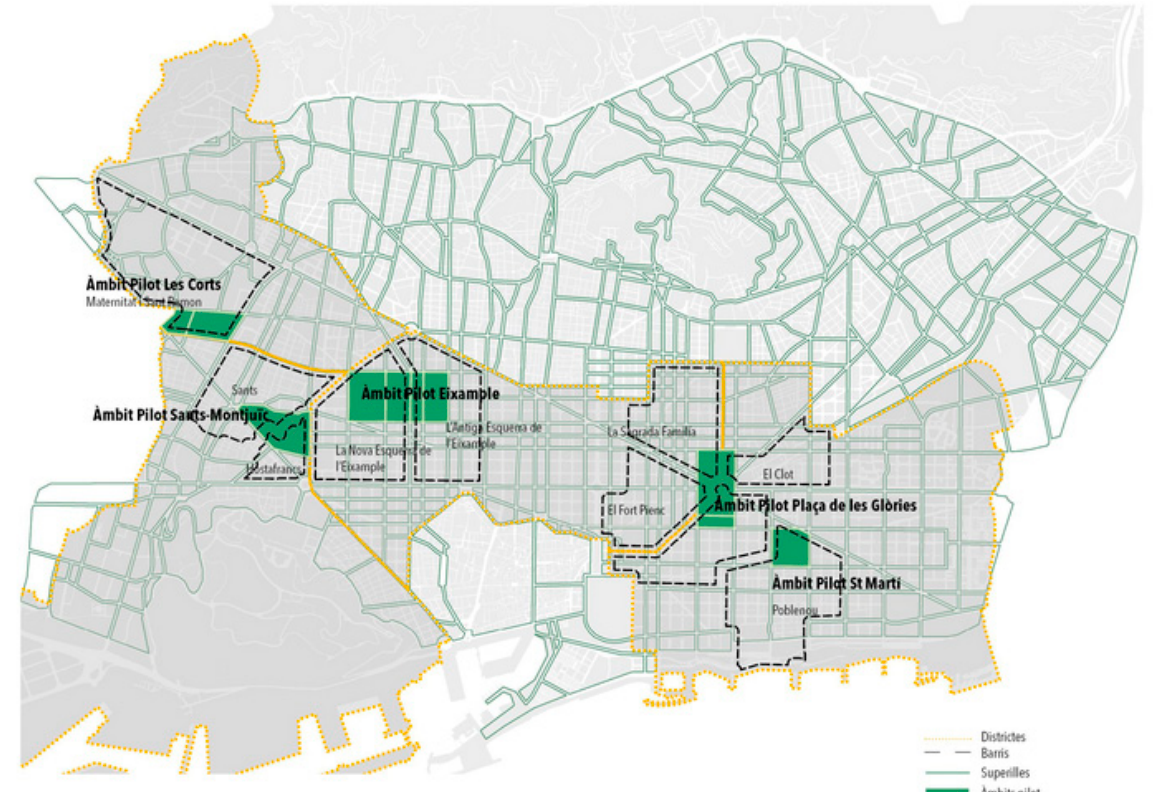
Figure 6. Pilot areas (in green) for the implementation of 5 superblocks in Barcelona, according to the Urban Mobility Plan 2013–2018. Source: La Vanguardia